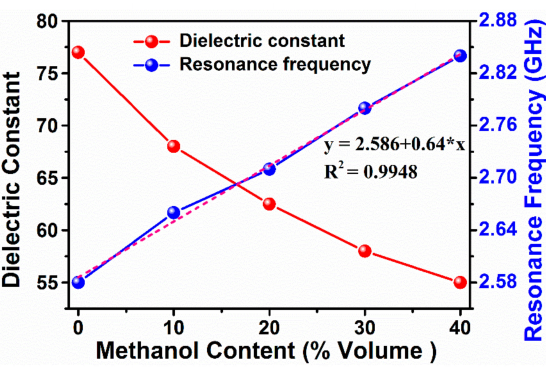
Figure 9. Dependence of resonance frequency on methanol volume